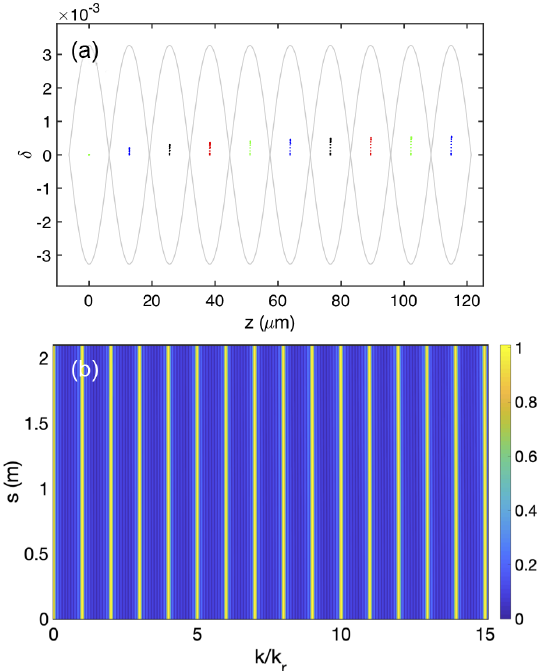
FIG. 13. Illustration of the coherent undulator radiation wake function (dashed line), its derivative (solid line), and a few microbunches for different bunch spacings. See the context for more discussions. The wake function is scaled to help